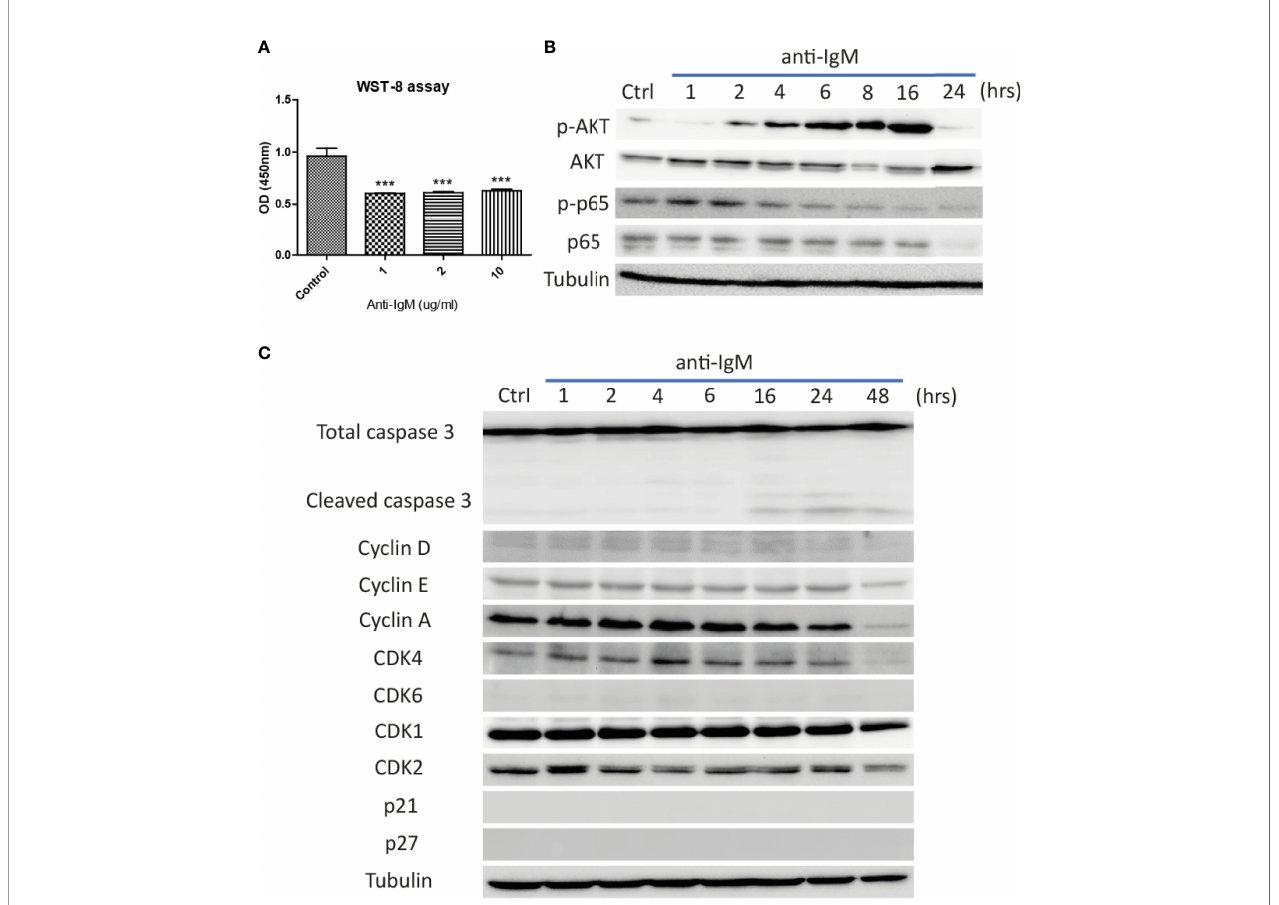
FIGURE 2 | Detrimental effects of anti-IgM on Ramos B cells. (A) Anti-IgM treatment signi fi cantly reduced proliferation after 48 hours in WST-8 assay. The detrimental effects were driven by (B) reduction in p65 signaling and AKT survival proteins, (C) activation of caspase 3 activity and downregulation of cell cycle related proteins after incubation of 2 µg/ml anti-IgM. ***p < 0.001 as compared to controls by one-way ANOVA, N =